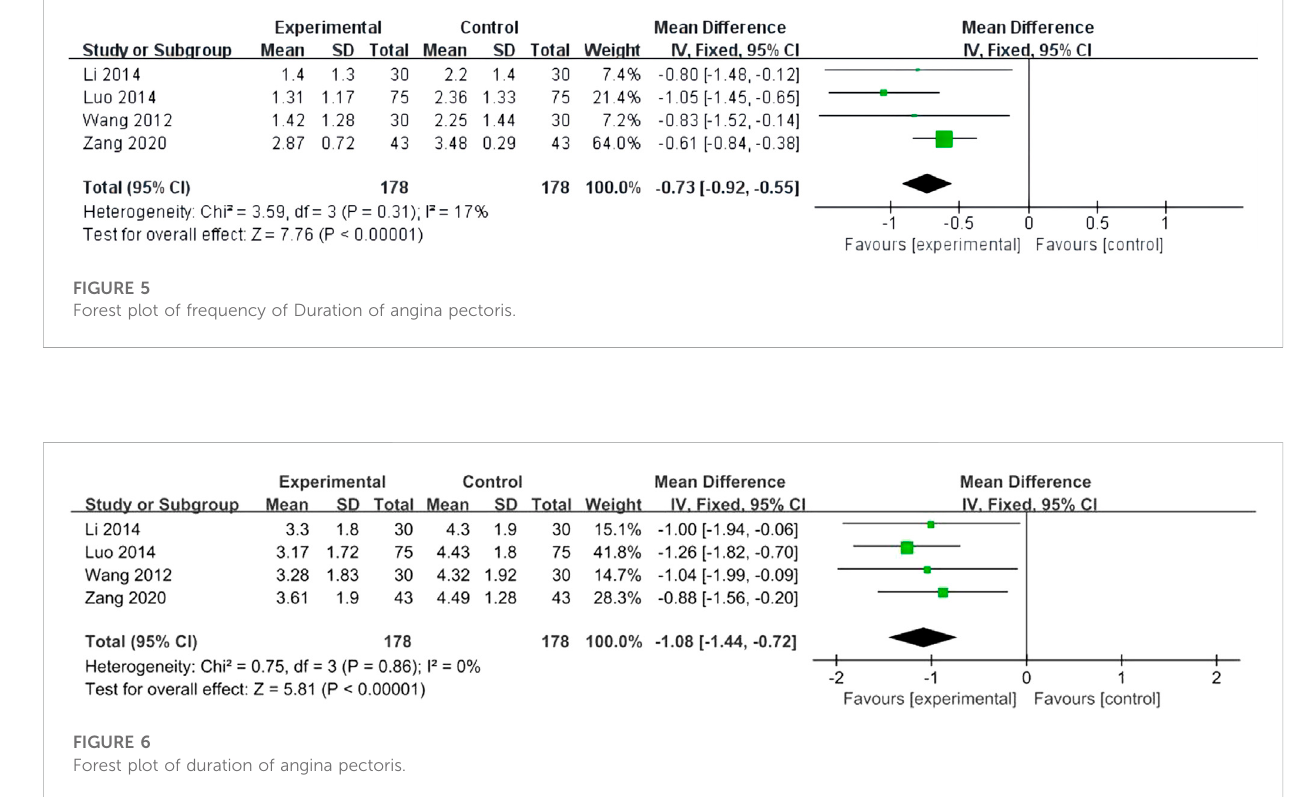
Figure 4), 450 mL of XST (RR = 1.38, 95% CI: 1.07 – 1.77, p = 0.01; Figure 4), 400 ml of XST (RR = 1.11, 95% CI: 1.02 – 1.21, p = 0.01; Figure 4), or less than 300 ml (RR = 1.26, 95% CI: 1.04 – 1.51, p = 0.02;